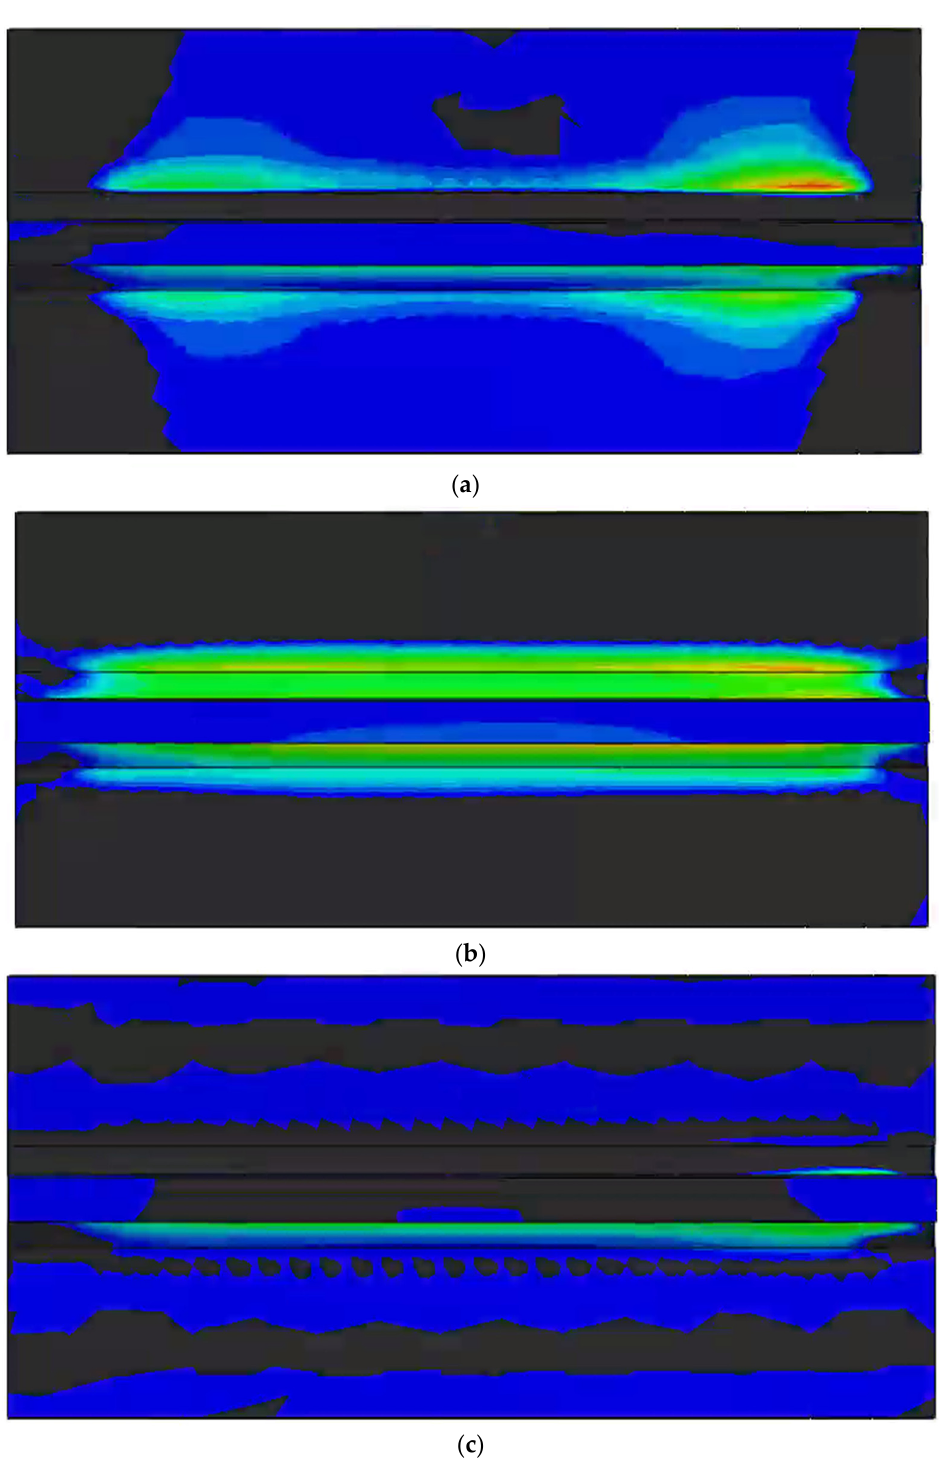
Figure 27. Tensile and compressive stress distribution: ( a ) X-directional; ( b ) Y-directional; ( c ) Z-directional.